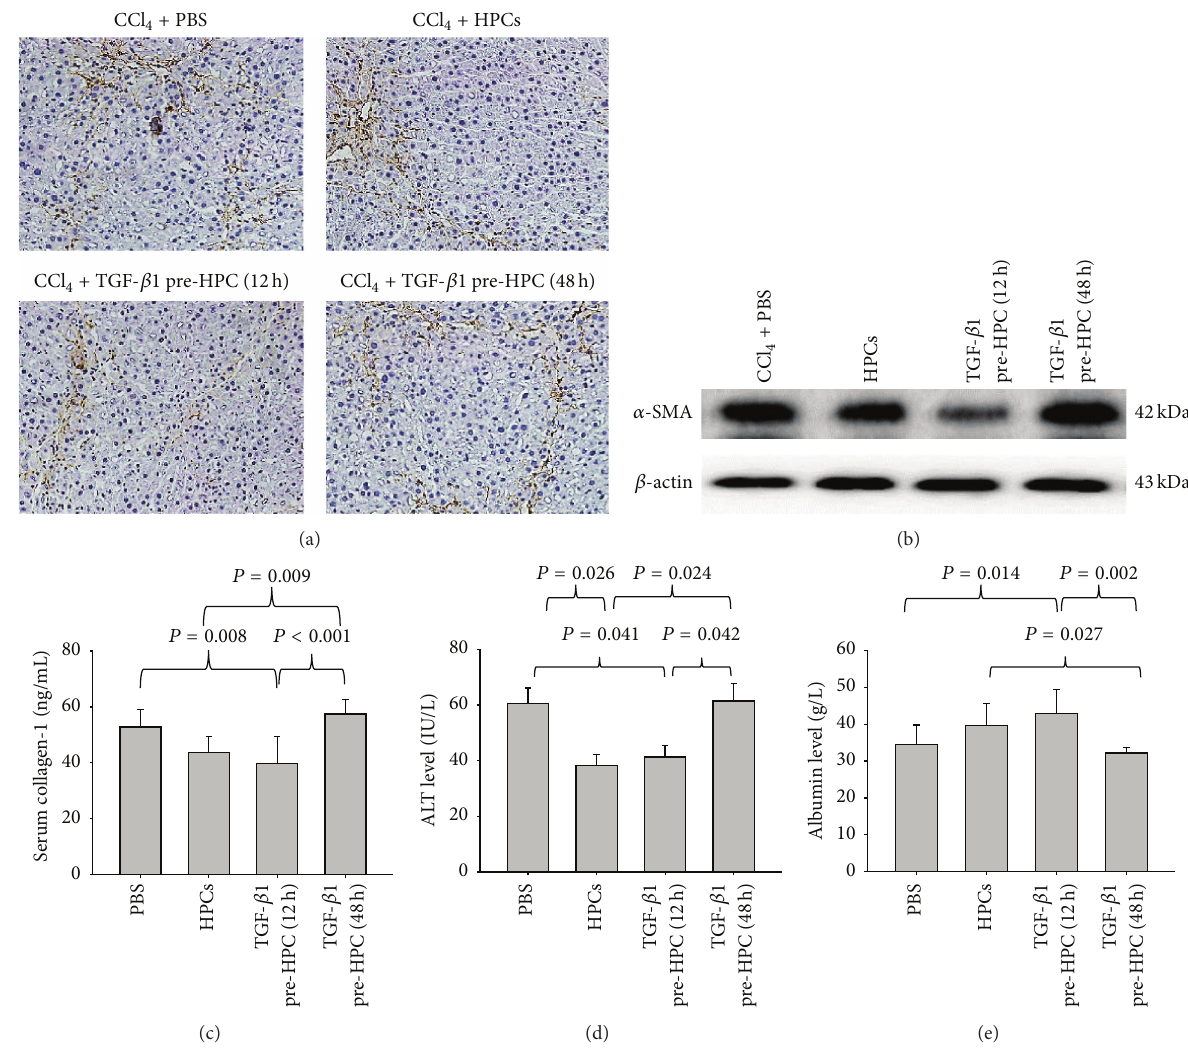
Figure 5: Fibrogenic markers of transplanted HPCs, HPCs pretreated with TGF- 𝛽 1 for 12h, and HPCs pretreated with TGF- 𝛽 1 for 48 h on recovery in the rat model with CCl 4 -induced injury. The expression of 𝛼 -SMA in liver tissues was detected by immunohistochemistry (a) and western blot (b). The expression levels of collagen-1 in liver tissues were measured by an enzyme-linked immunosorbent assay (c). ALT (d) and ALB (e) in the blood samples collected at the end of the experiment were analyzed. All data are expressed as the mean ± SD from three independent